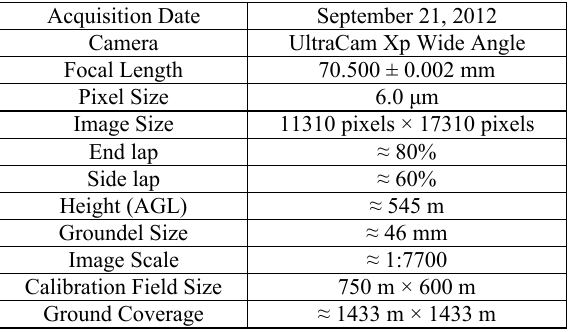
Table 1. The parameters of the test images